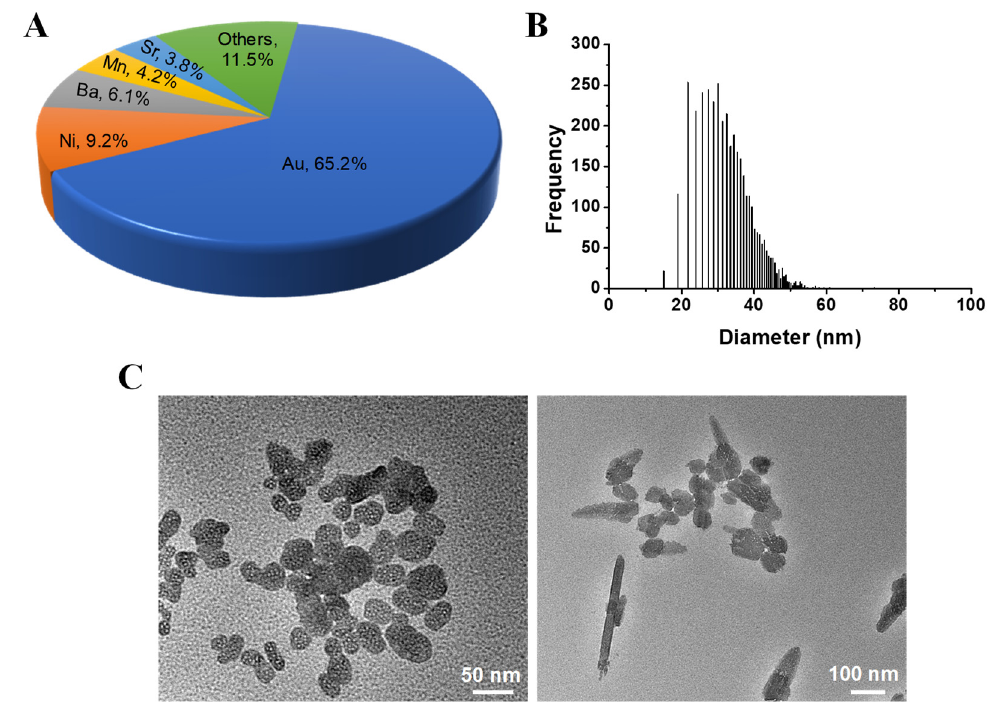
Figure 1. Analysis of commercial facial cream that contains Au NMs. ( A ) Metal composition ana- lyzed by ICP − MS; ( B ) distribution of Au NMs; ( C ) TEM image of Au NMs. by ICP − MS; ( B ) distribution of Au NMs; ( C ) TEM image of Au